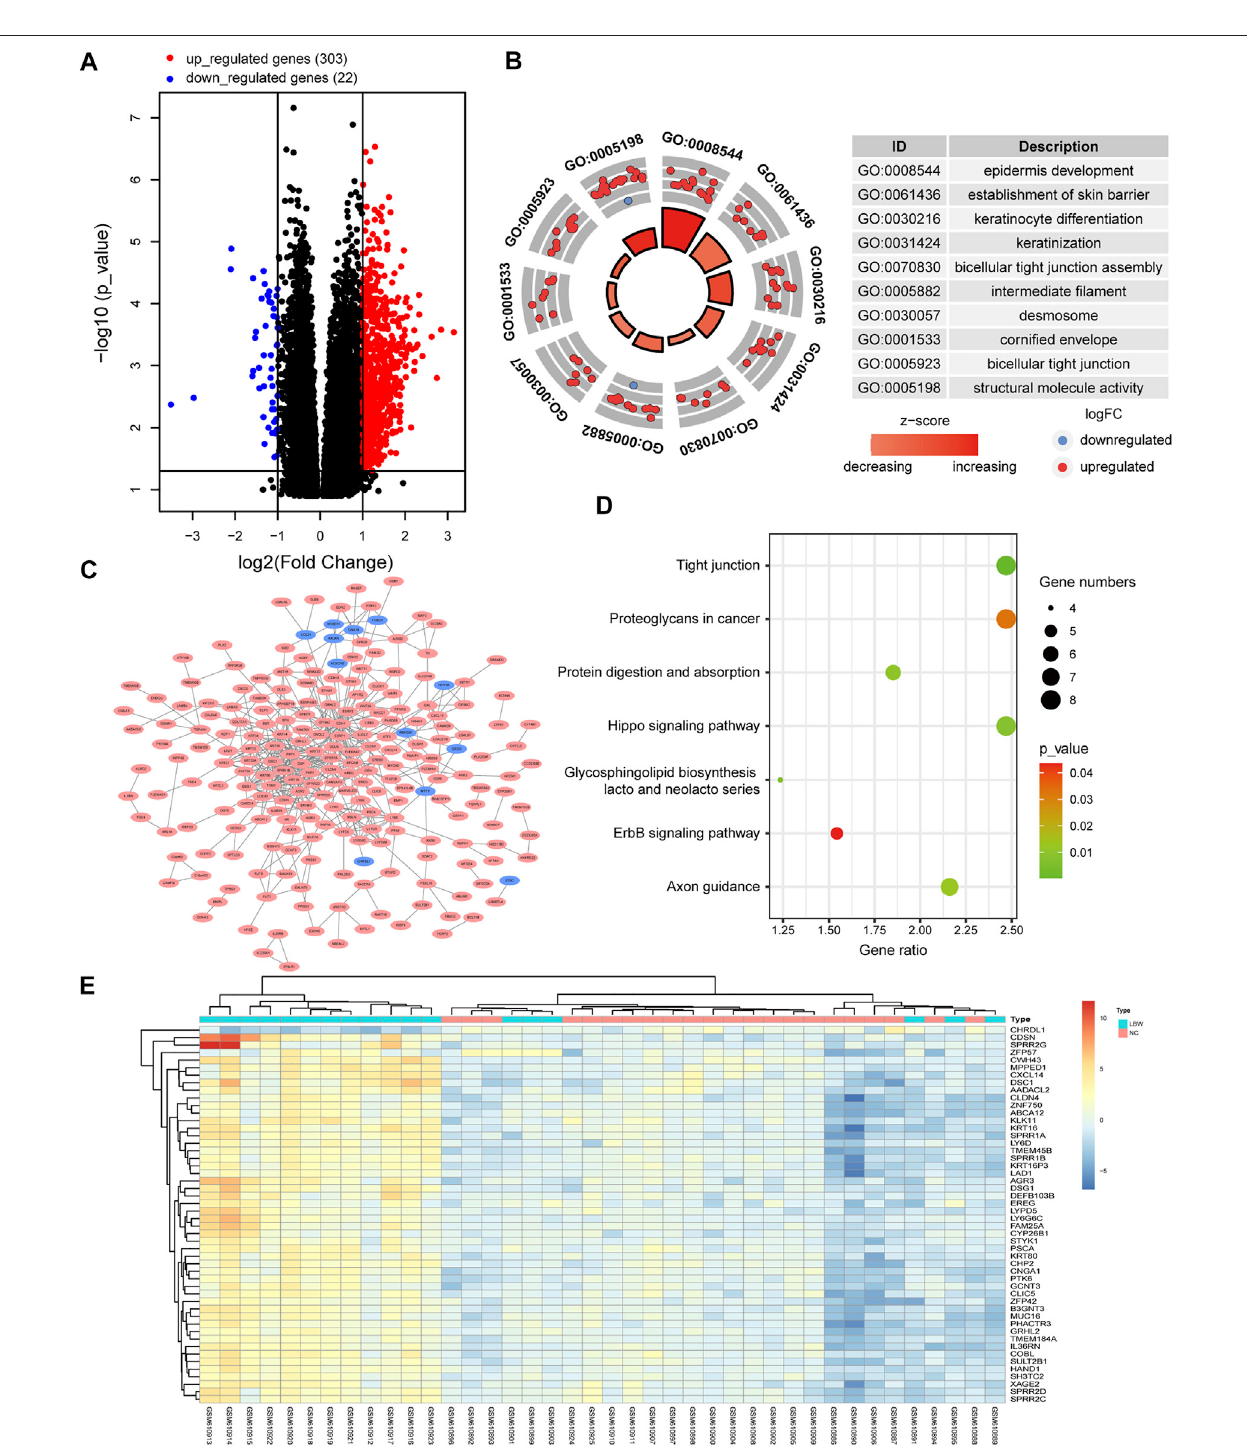
FIGURE3| Analysisofthegeneexpressionpro fi ledatasetrelatedtohumaninfantswithLBW(GSE24818). (A) Volcanomap.Theredpointsrepresentupregulated genes selected based on the corrected p-value < 0.05 and logFC > 1. The blue points represent downregulated genes selected based on the corrected p-value < 0.05 and logFC < − 1. The black points represent genes with no signi fi cant difference. (B) GO enrichment analysis of DEGs. (C) PPI network analysis of DEGs. (D) KEGG pathway analysis of DEGs. (E) Heat map. The heat map displays the fi rst 50 DEGs with the highest | logFC | using the pheatmap package of R software. Red indicates that genes are expressed at a relatively high level. Blue indicates that genes are expressed at a relatively low level. Yellow is set in the middle. LBW, low birth weight; FC, fold change; GO, Gene Ontology; DEGs, differentially expressed genes; KEGG, Kyoto Encyclopedia of Genes and Genomes; PPI, protein – protein